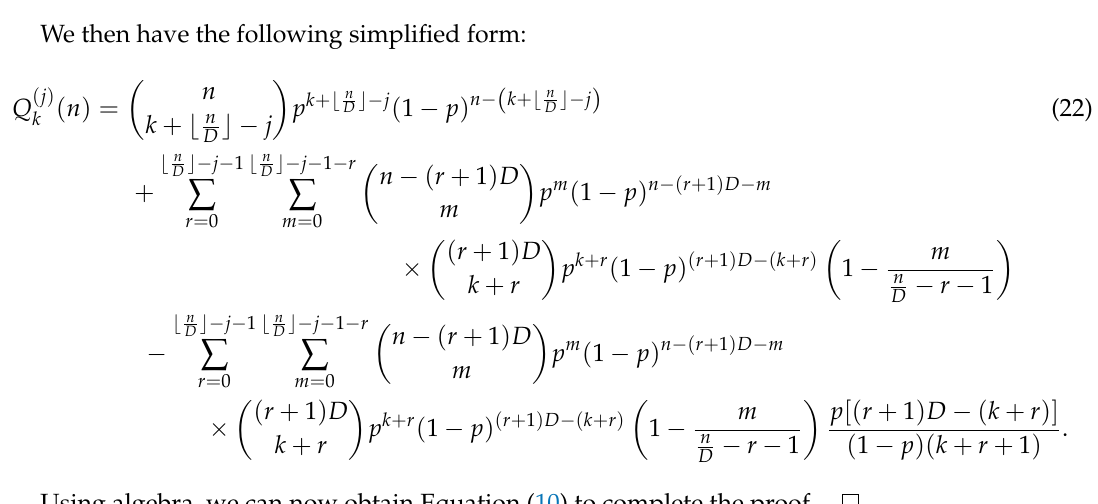
( 2 ) ( n ) , Q ( 2 ) ( n ) , Q ( 2 ) ( n ) and Q ( 2 ) 0 2 1